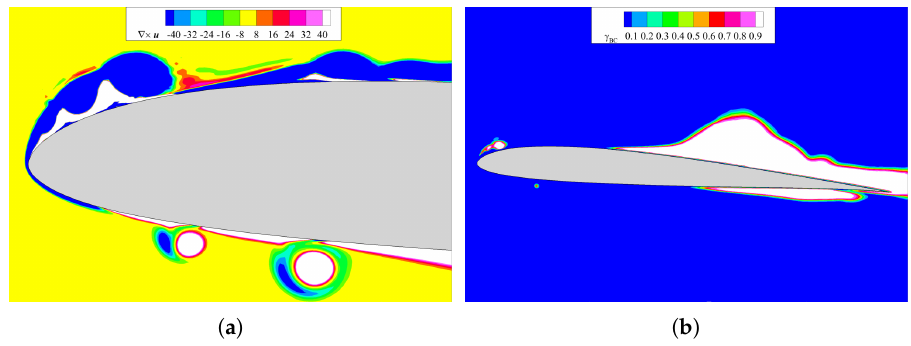
Figure 11. SA − BCM model. Vertical position Φ = 0.35. Contour of instantaneous spanwise vorticity ( a ) and intermittency function γ BC ( b ).